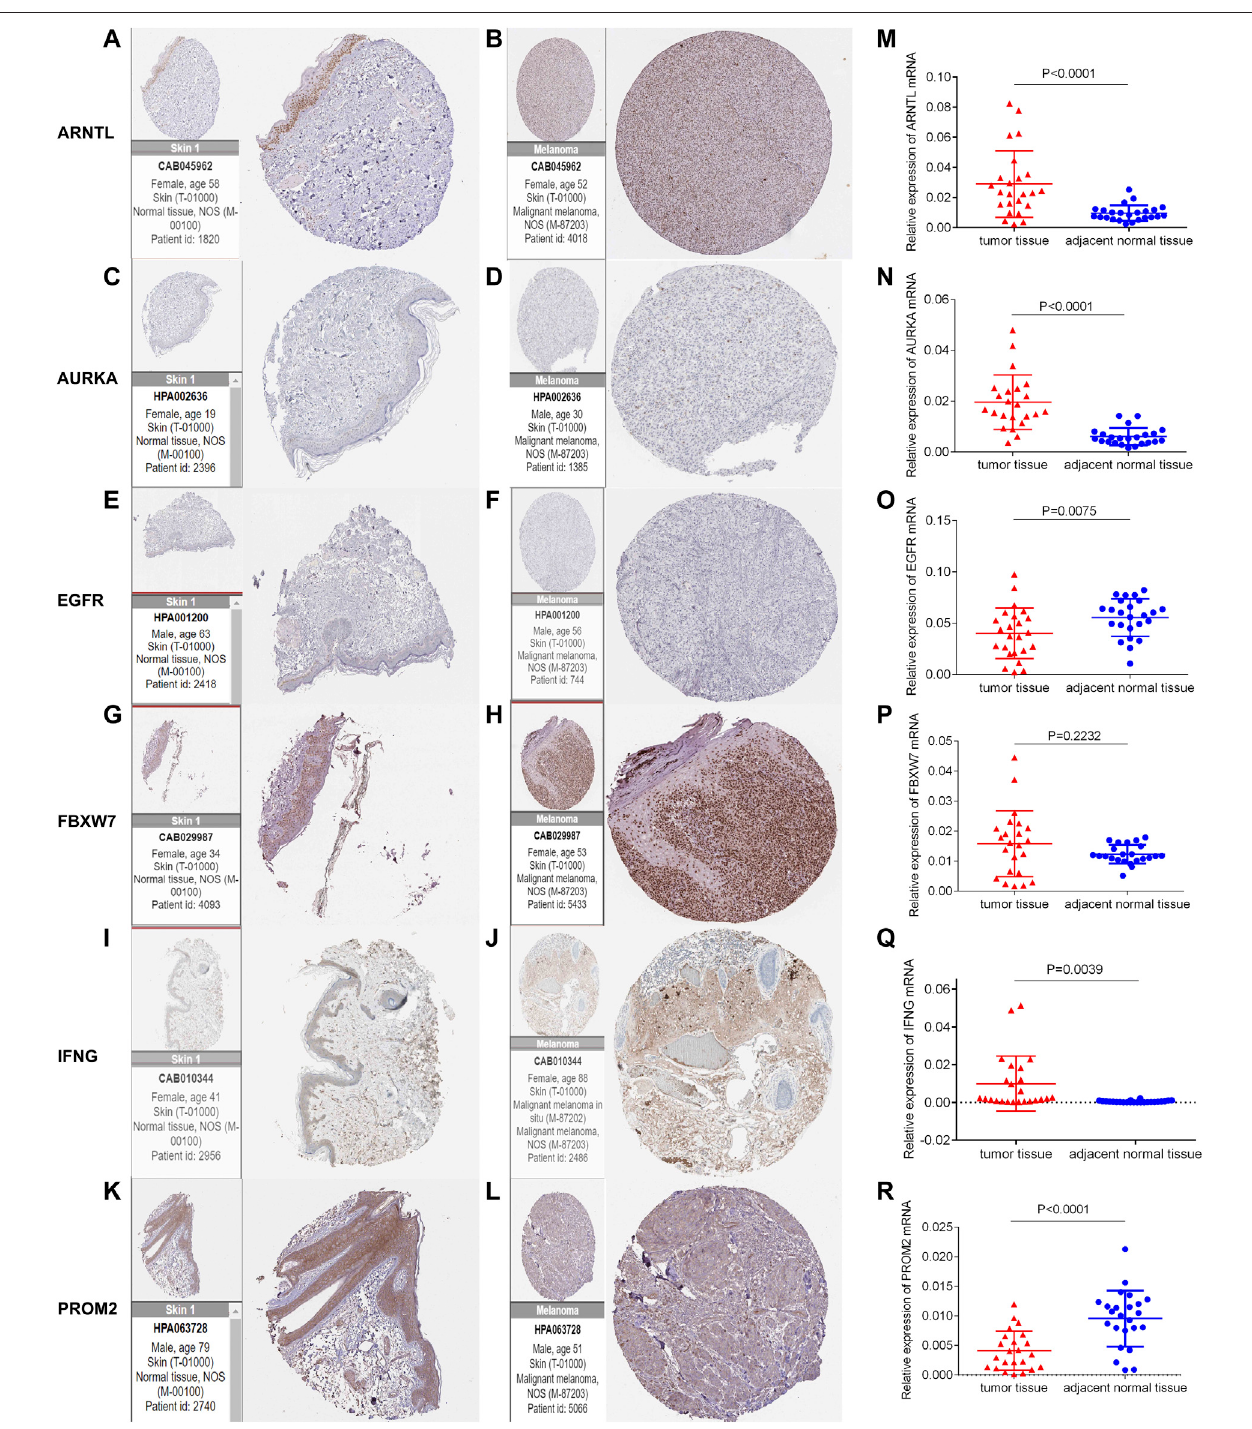
FIGURE 10 | Immunohistochemistry of six genes in normal skin tissues and melanoma tissues (A-L). The mRNA expression level of six genes in 24 pairs of melanoma tumor and adjacent normal tissues was measured by qRT-PCR (M-R).